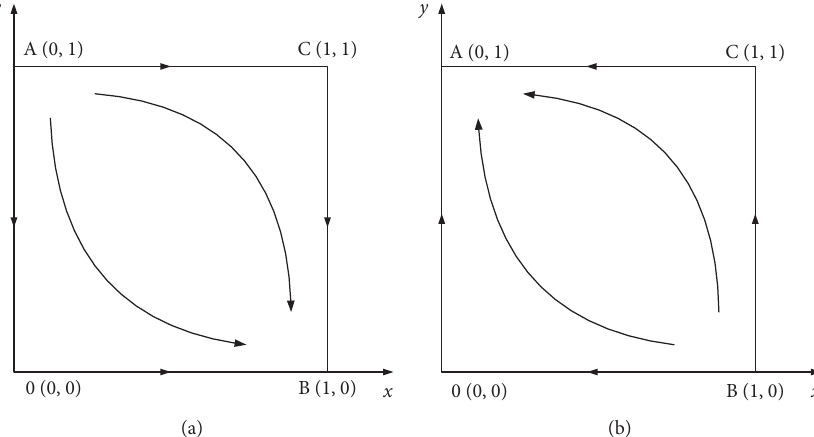
Figure 3: Evolutionary game phases diagrams. In situation VII, the ESS is point B (1, 0). In situation VIII, the ESS is point A (0, 1). (a) Situation VII. (b) Situation VIII.